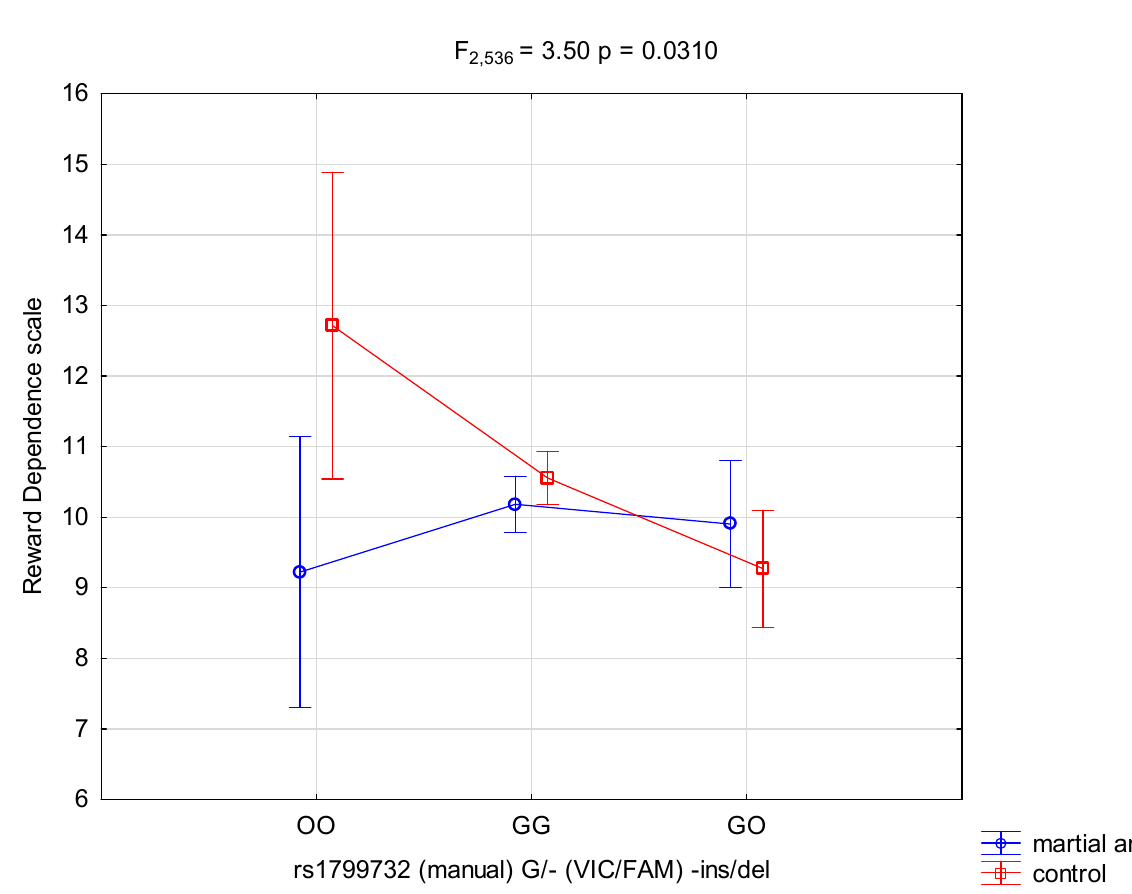
Figure 1. Interaction between martial arts/-control and DRD2 rs1799732 (manual) G/-(VIC/FAM)-ins/del and RD-Reward Dependence scale.